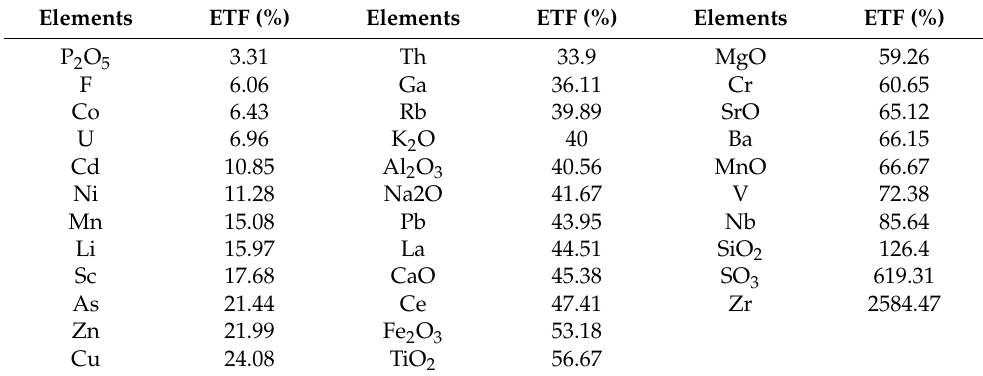
Table 6. Element transfer factor (ETF) of major and trace elements.